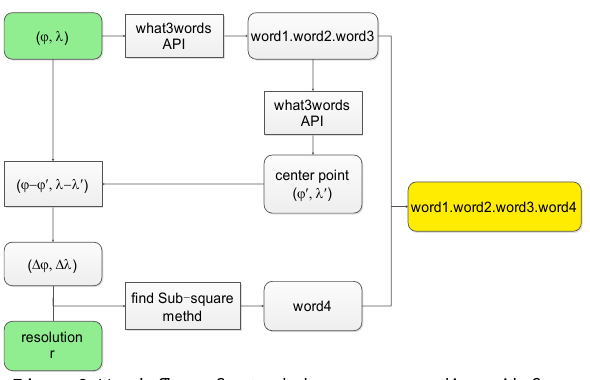
Figure 6. Work flow of extended reverse geocoding with four-